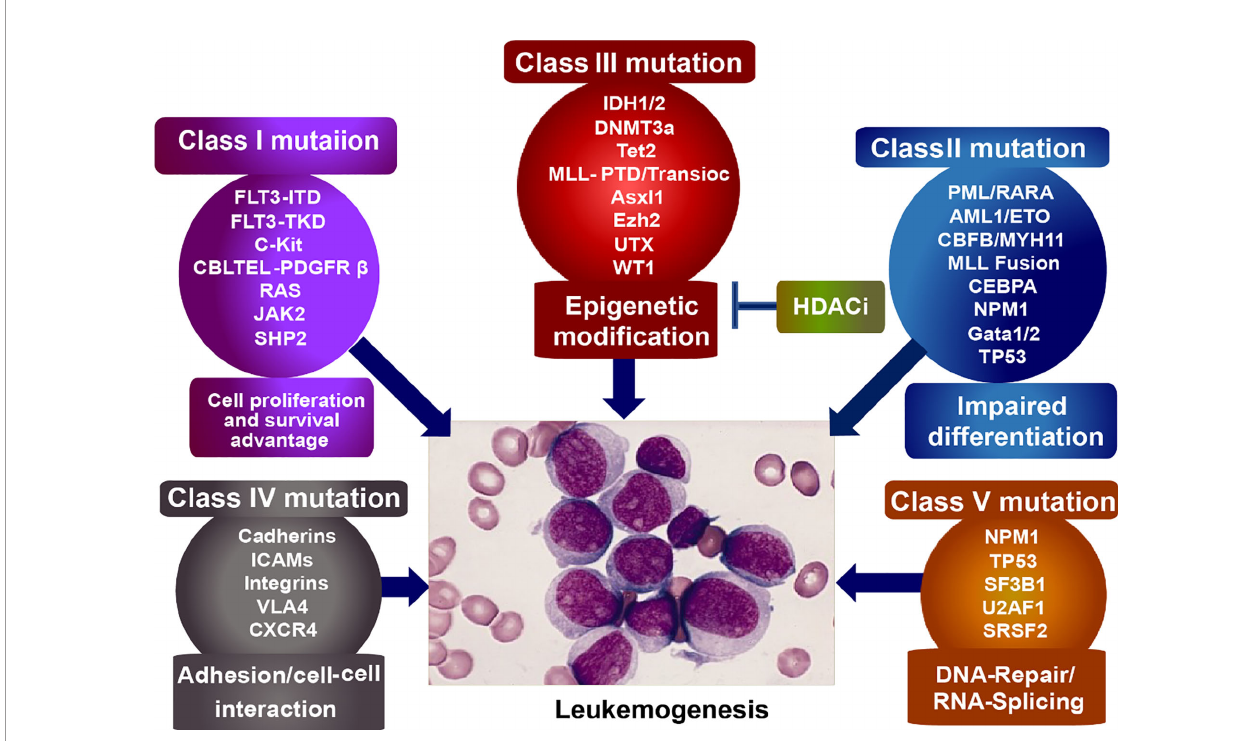
FIGURE 1 | Classi fi cation of mutagenic genes eliciting leukemogenesis. Class I mutation, provides tumor cells with survival/proliferation advantages; Class II mutation, disturbs the cell differentiation; Class III mutation, epigenetically dysregulates the tumor suppressor/activator; Class IV mutation, alters cell adhesion and cell-cell interaction, leading to the fl exible motility and migration. Class V mutation, dysregulates DNA-repair and